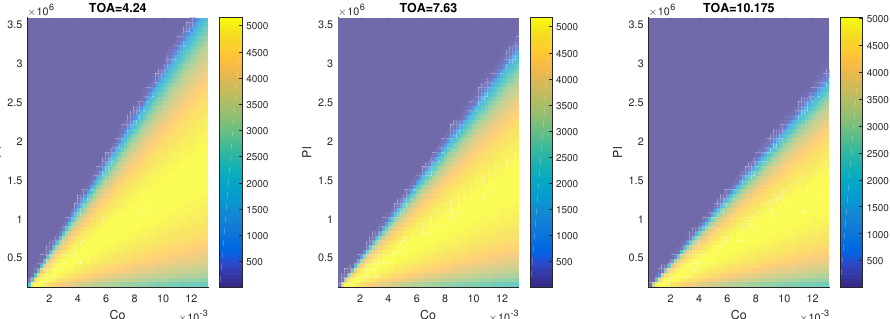
Figure 5. Amplitude of the pressure rise oscillations as a function of Co and Pl for different values of TOA